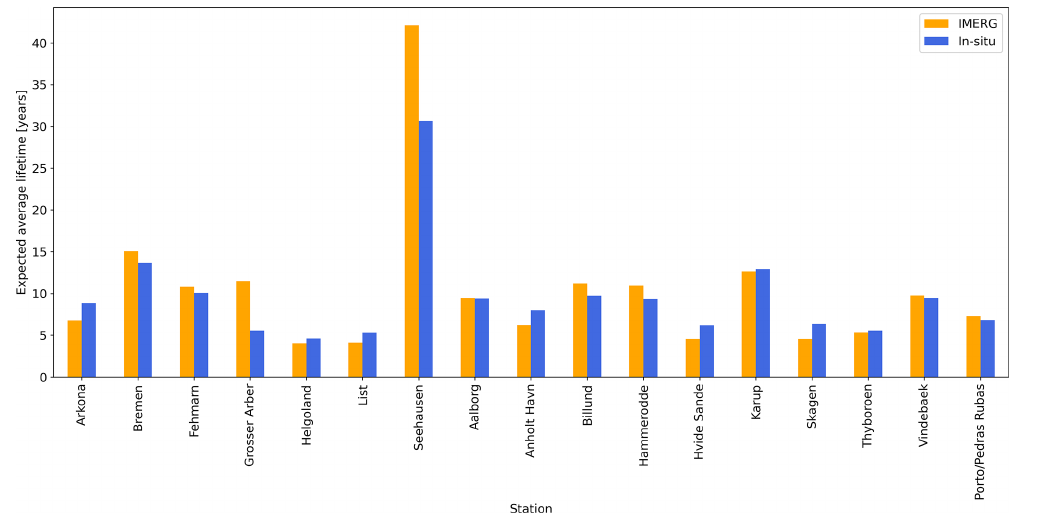
Figure 10. Blade lifetimes estimated using 30min accumulated rainfall intensities from IMERG and the in situ stations. Note that the Portuguese station Viana do Castelo/Chafé is left out due to a limited wind data availability.